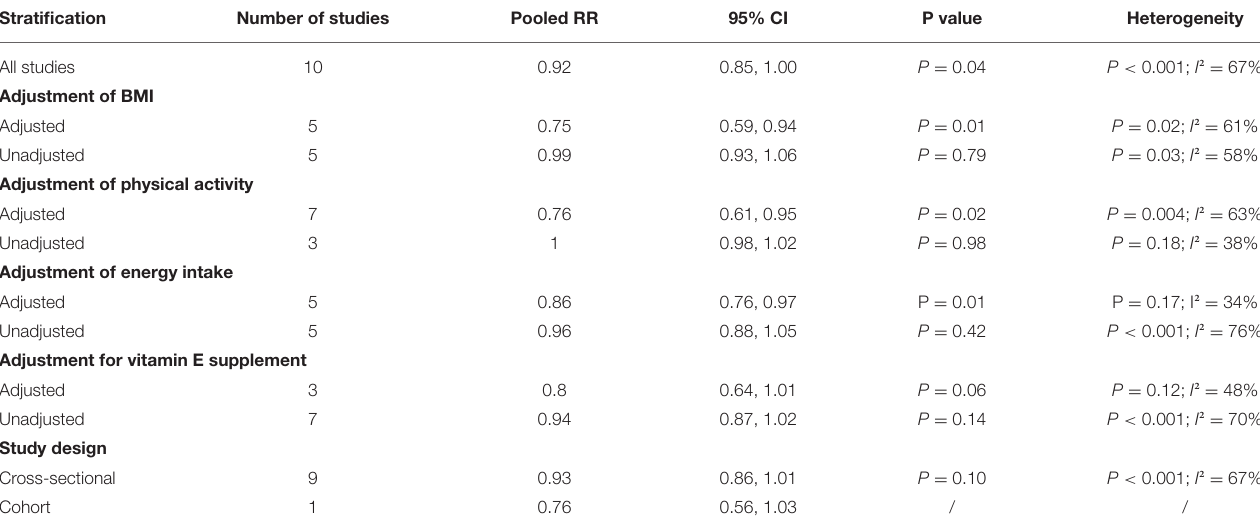
TABLE 2 | Subgroup analysis of MetS for the highest vs. lowest dietary vitamin E level